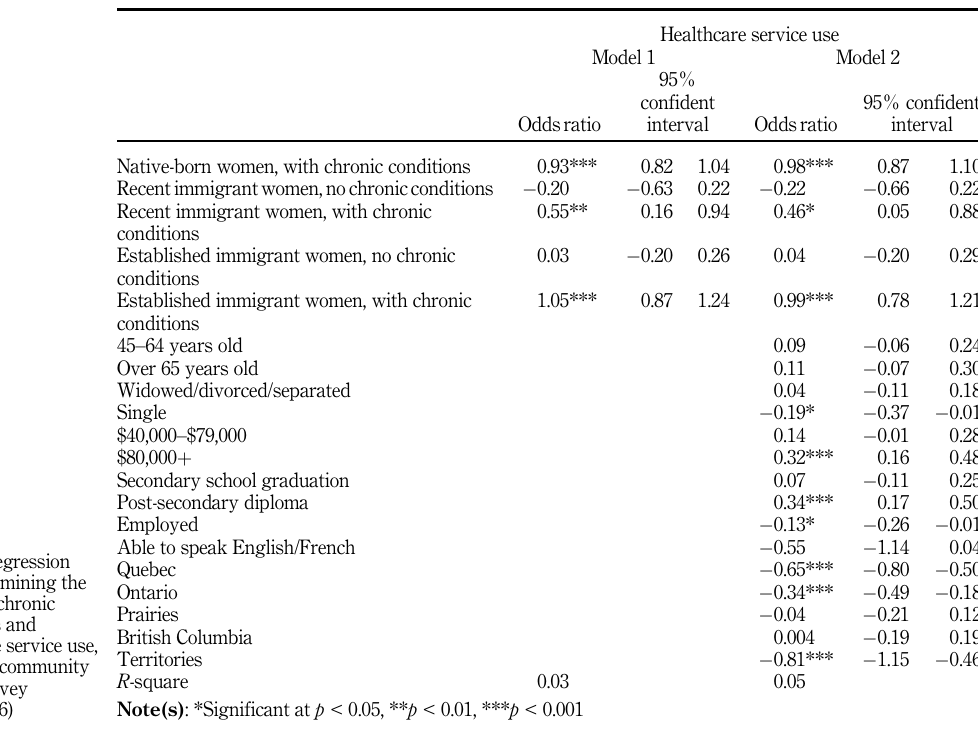
Table 4. Logistic regression model examining the effects of chronic conditions and healthcare service